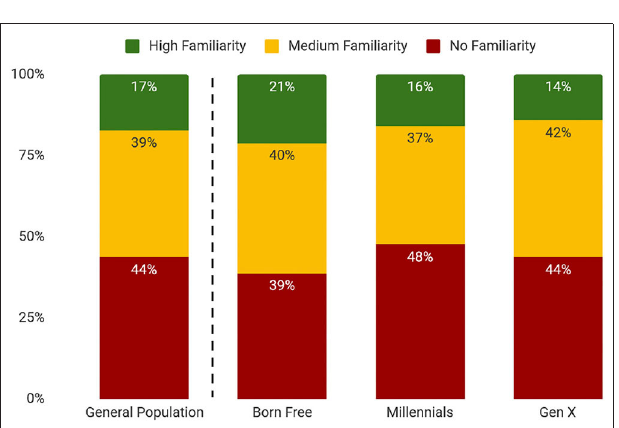
FIGURE 1 | Current familiarity with plant-based and cultivated meat in the general population.